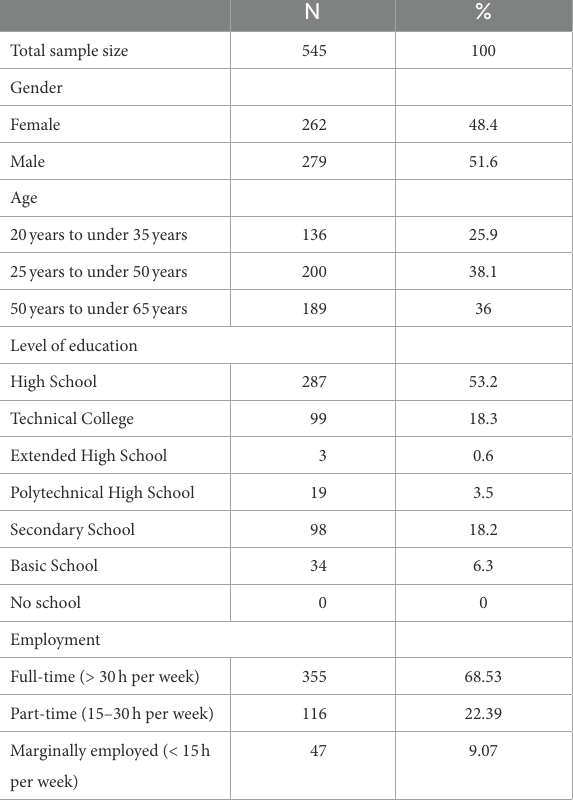
TABLE 3 Sociodemographic characteristics of